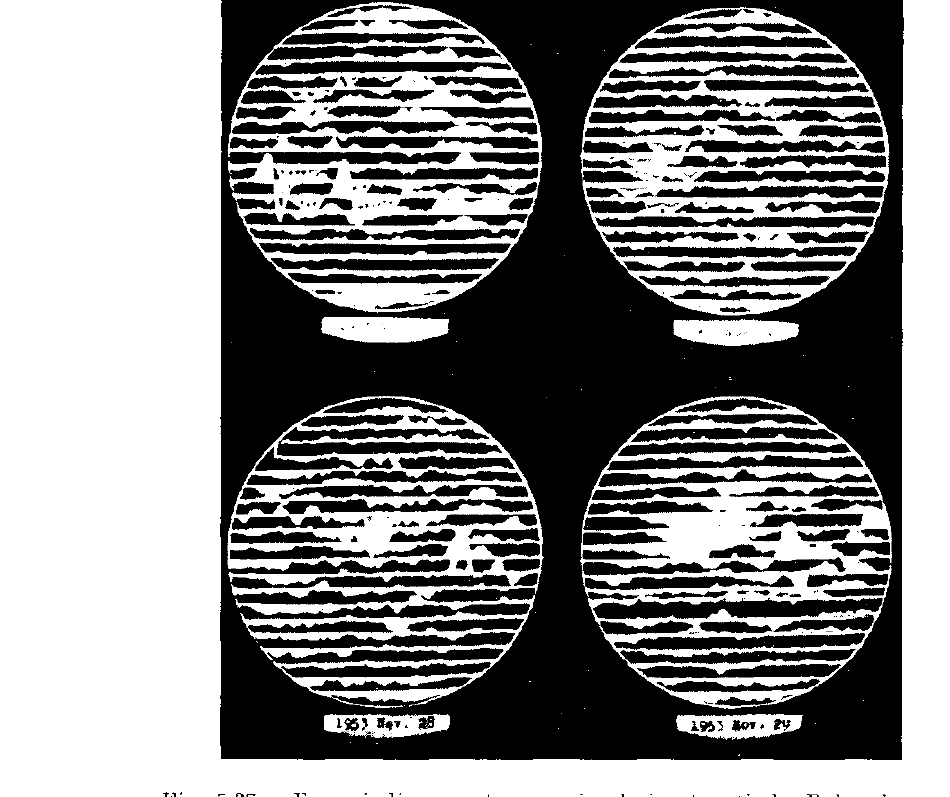
Fig. 5.37 - Esempi di maguetogrammi solari ottenuti da Babcock: sono visibili regioni BM e UM, noneliò polarità opposte e piuttosto uniformi nelle due calotte polari (secondo